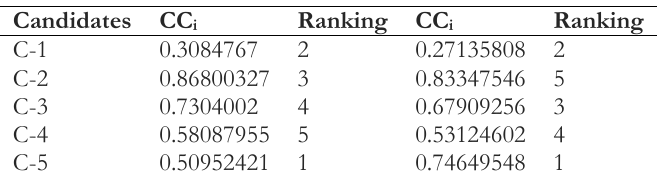
Table 15. The similarity coefficients (CCi) and the ranking of the candidates according to the worst similarity with the first and second modifications of TOPSIS in the two left and two right columns,